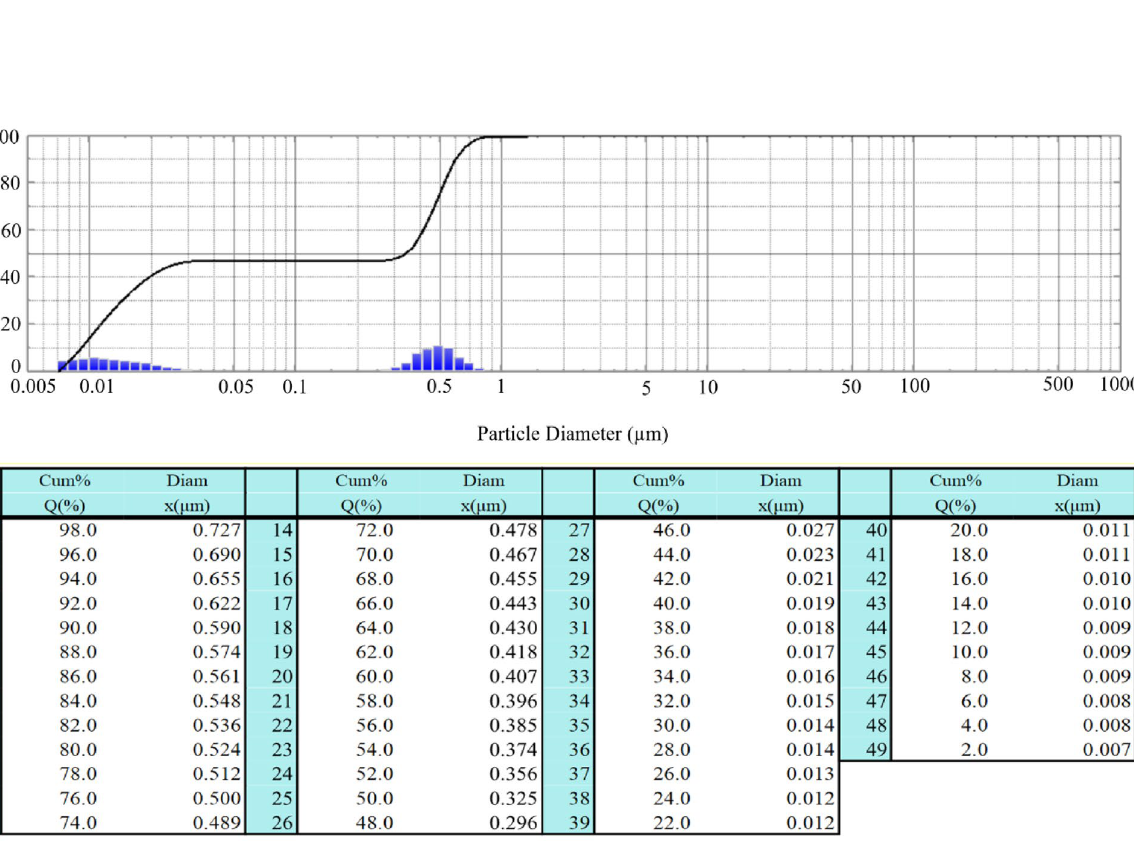
Figure 6. Silica particle size distribution for the sample water + SiO 2 24 h after the preparation of the